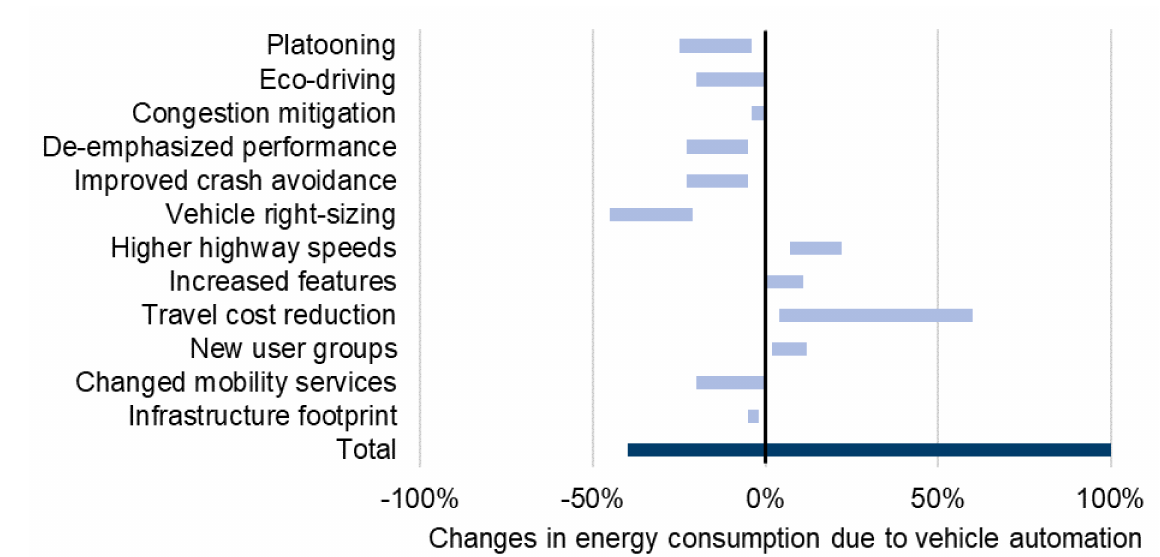
Figure 6. Changes in energy consumption due to vehicle automation